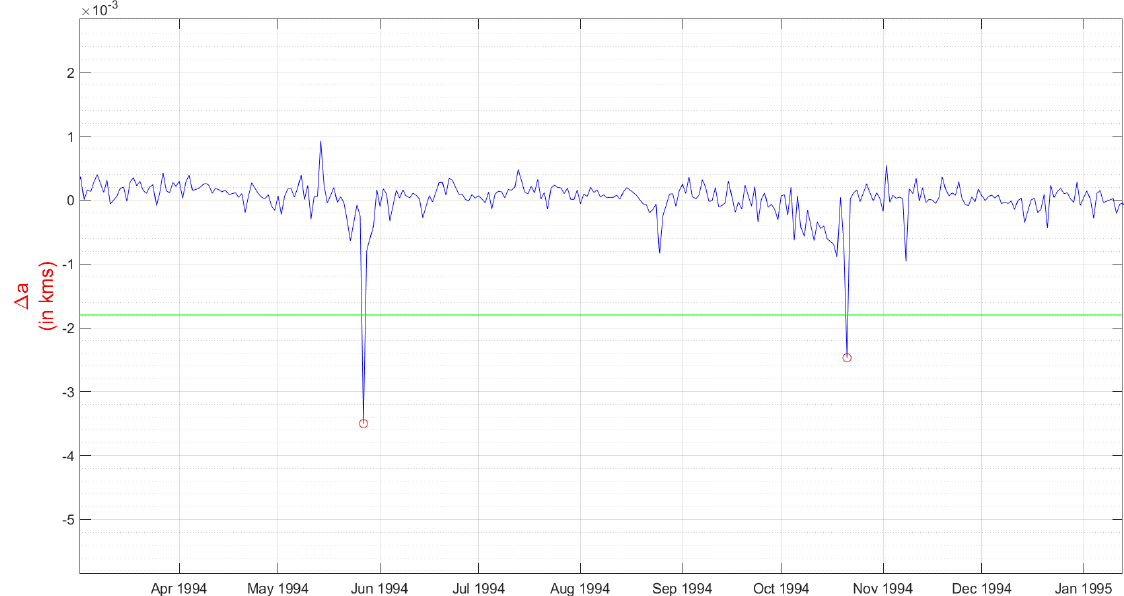
Figure 2. Difference between the propagated and the observed semimajor axis of TOPEX. Horizontal green line is the detection